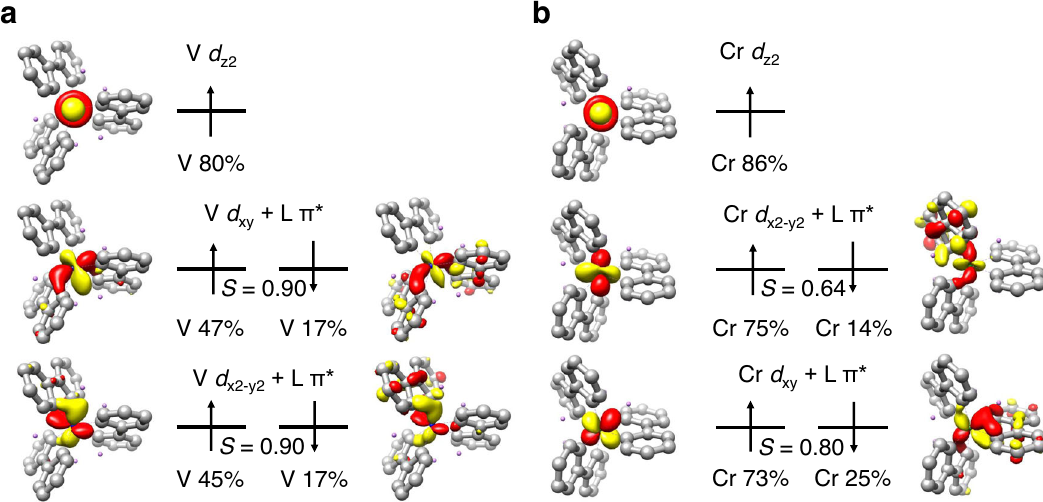
Fig. 3 Schematic MO diagrams. S is the spatial overlap between the two orbitals of a given spin coupled pair. Schematic MO diagrams of complexes 2 ( a ) and 3 ( b